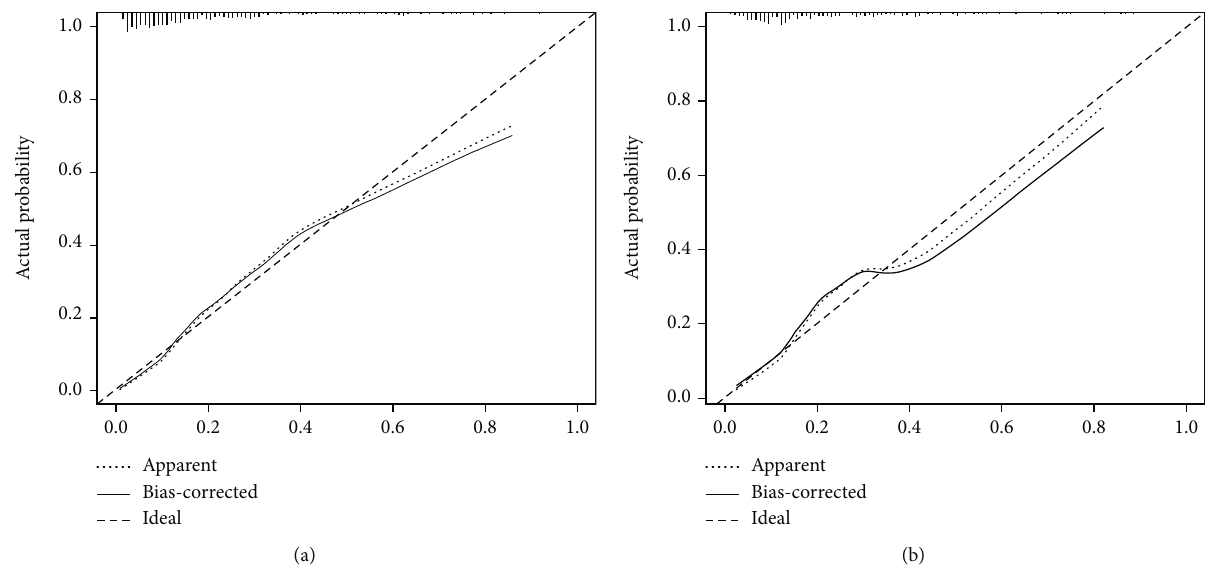
Figure 5: Calibration curve of the nomogram on the data of the training set (a) and validation set (b).